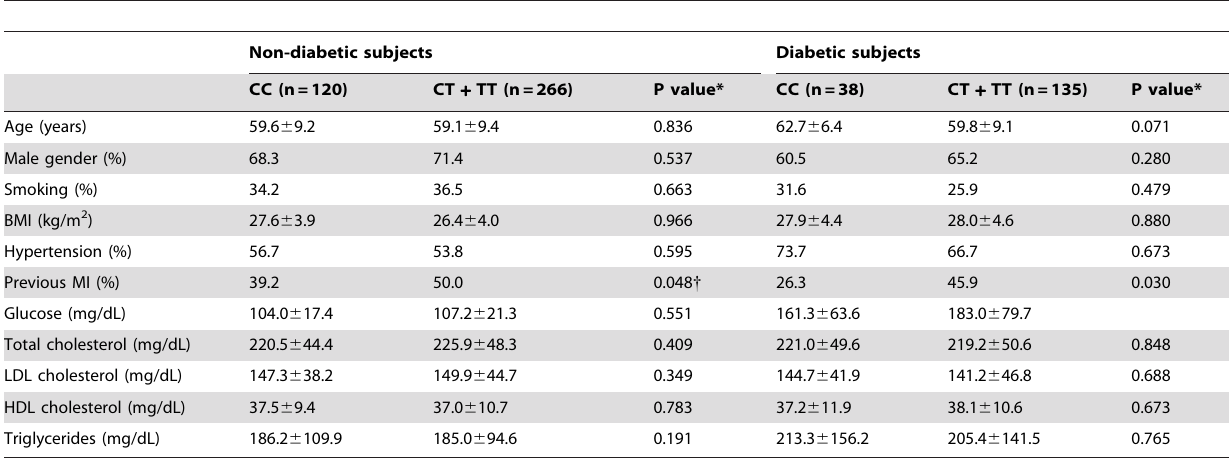
Table 5. Demographic and laboratorial characteristics of non-diabetic subjects from the MASS-II population according to TCF7L2 genotype.